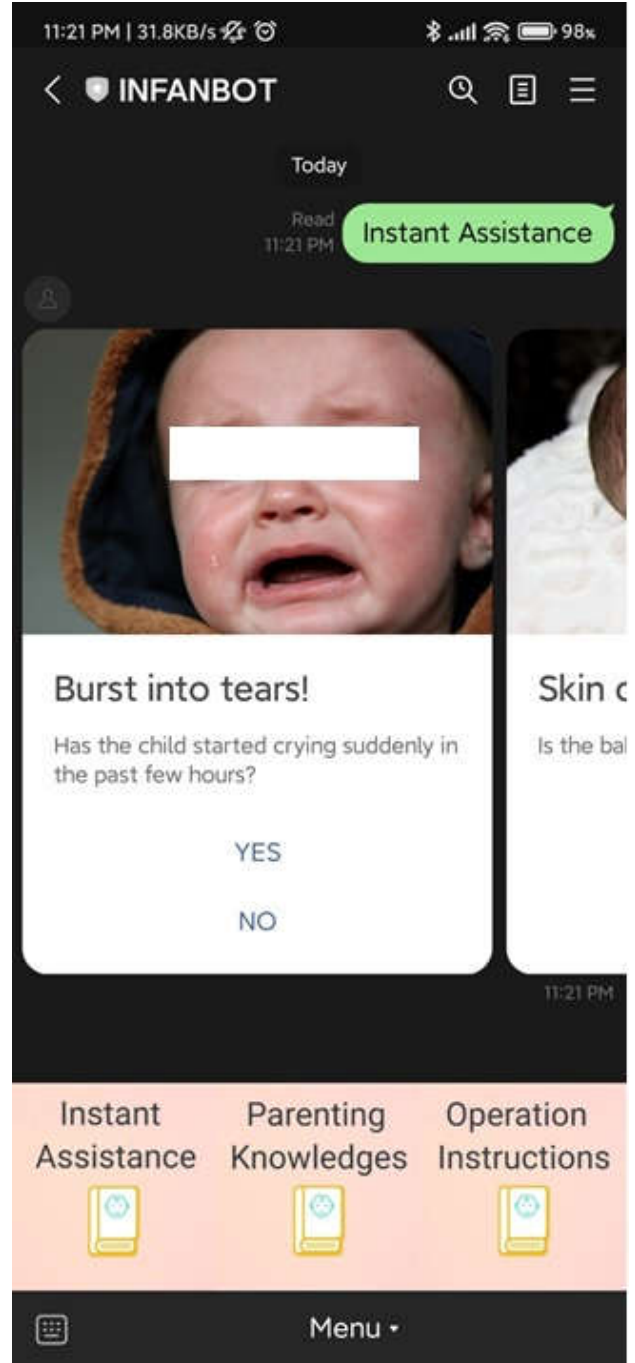
Figure 4. The “Instant Assistance menu.”.